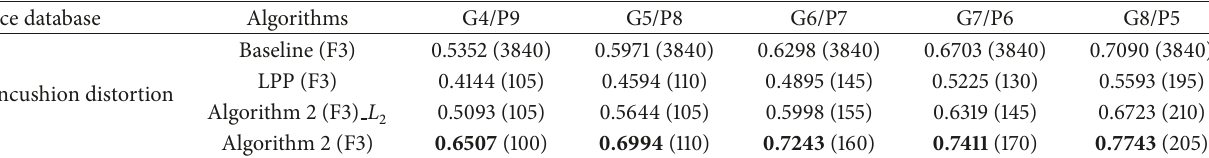
Table 14: The recognition rates on pincushion distortion AR face database over “F3” features; recognition rates (dimensionality).